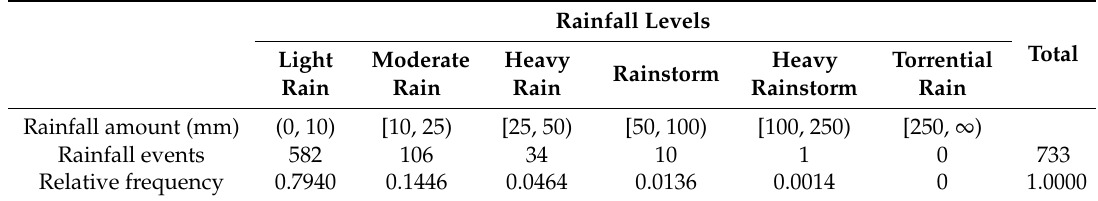
Table 4. Rainfall frequency of all intensity levels in 2005–2015 growing seasons. Rainfall